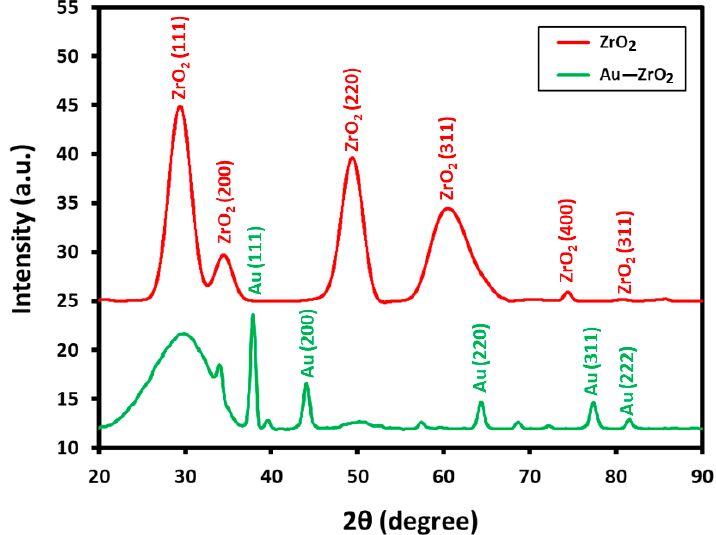
Figure 3. XRD diffractograms of Au-ZrO 2 and pristine ZrO 2 NPs depicting the cubic phase of both Au and ZrO 2 nanoparticles in Au-ZrO 2 .